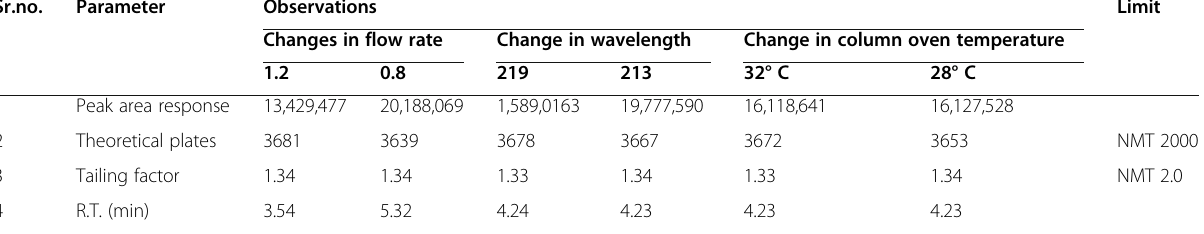
Table 16 Result of robustness Sr.no.